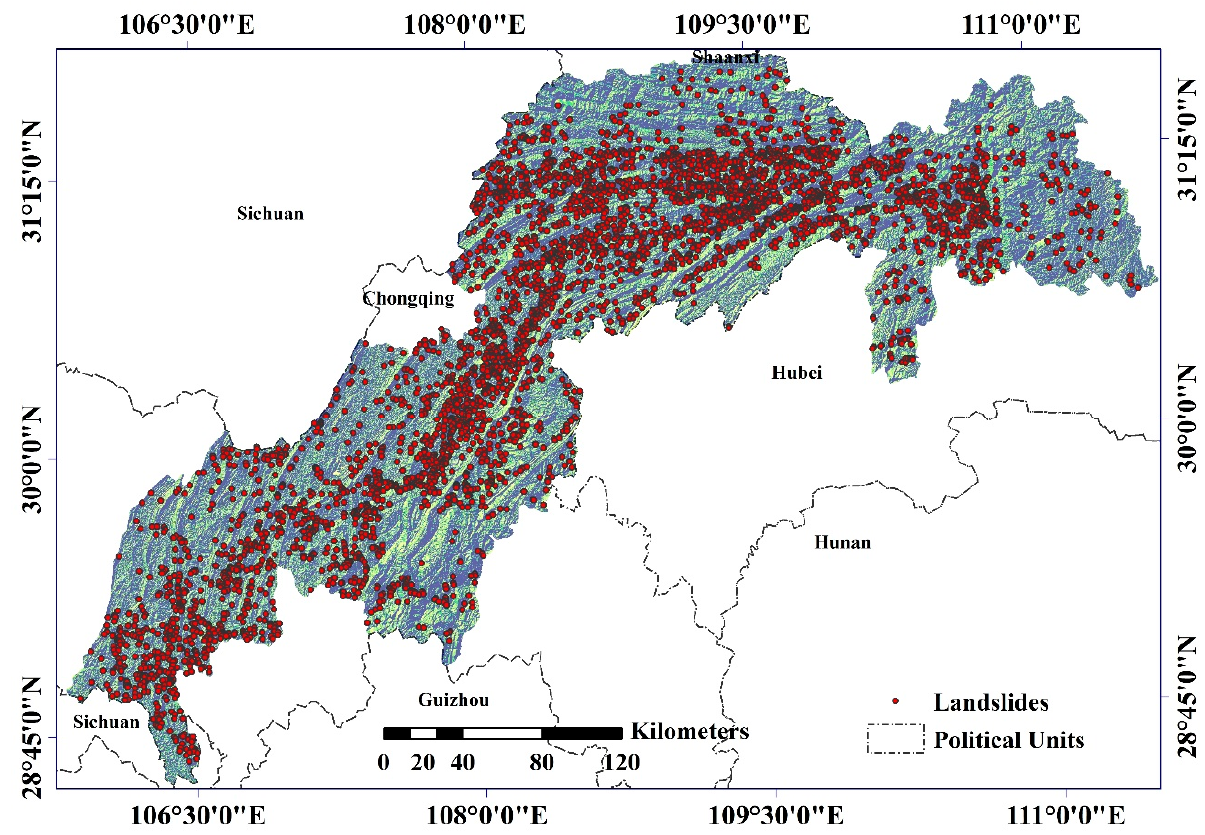
Figure 3. The spatial distribution of landslide points in the Three Gorges Reservoir